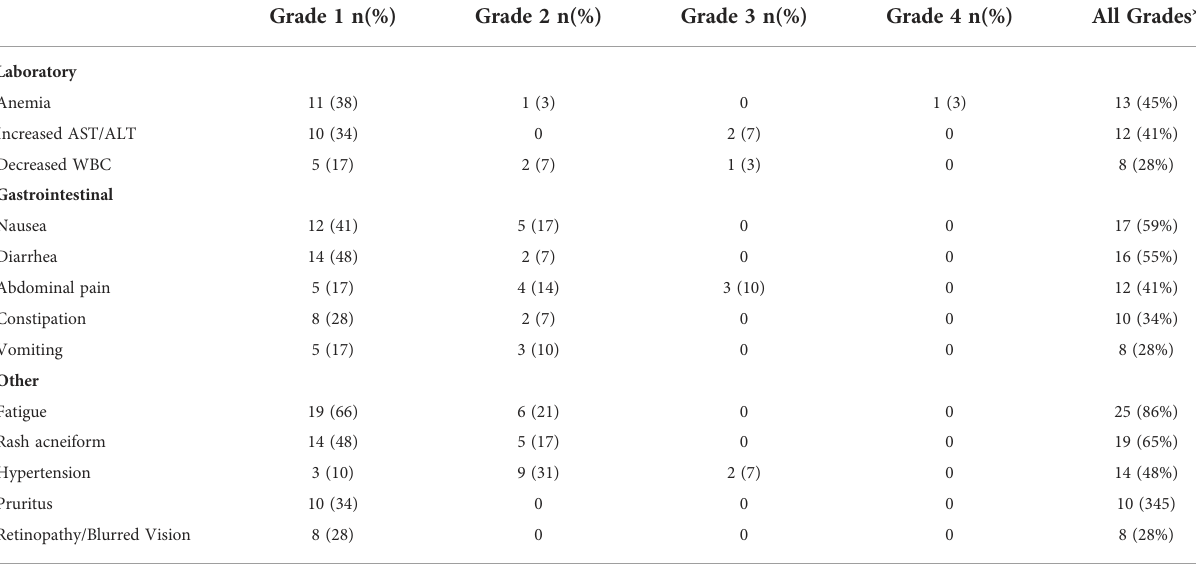
TABLE 2 Adverse events (all grades, occurring in ≥ 10% of patients) possibly, probably or de fi nitely related to study treatment.